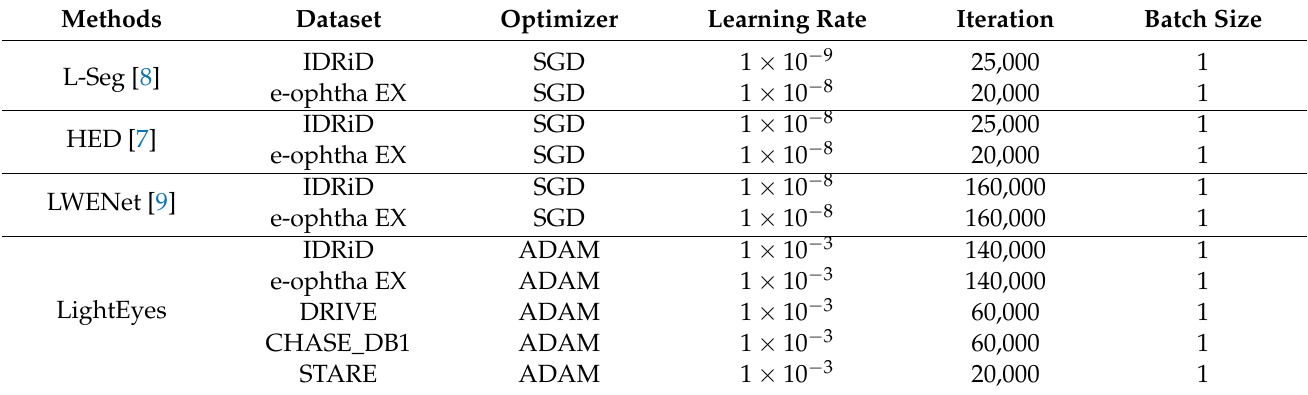
Table 3. Hyperparameter settings of LightEyes and comparison